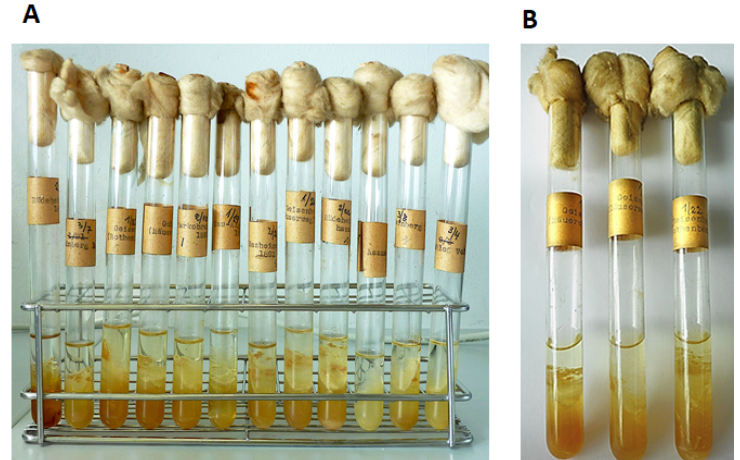
Figure 1. ( A , B ). Old samples from the Geisenheimer Yeast Breeding Center. Samples were generated as agar slants with yeasts grown and covered in vaspar. Tubes were plugged by a cotton ball. Samples were labeled according to the location of the isolate and the year of isolation (see Table 1).